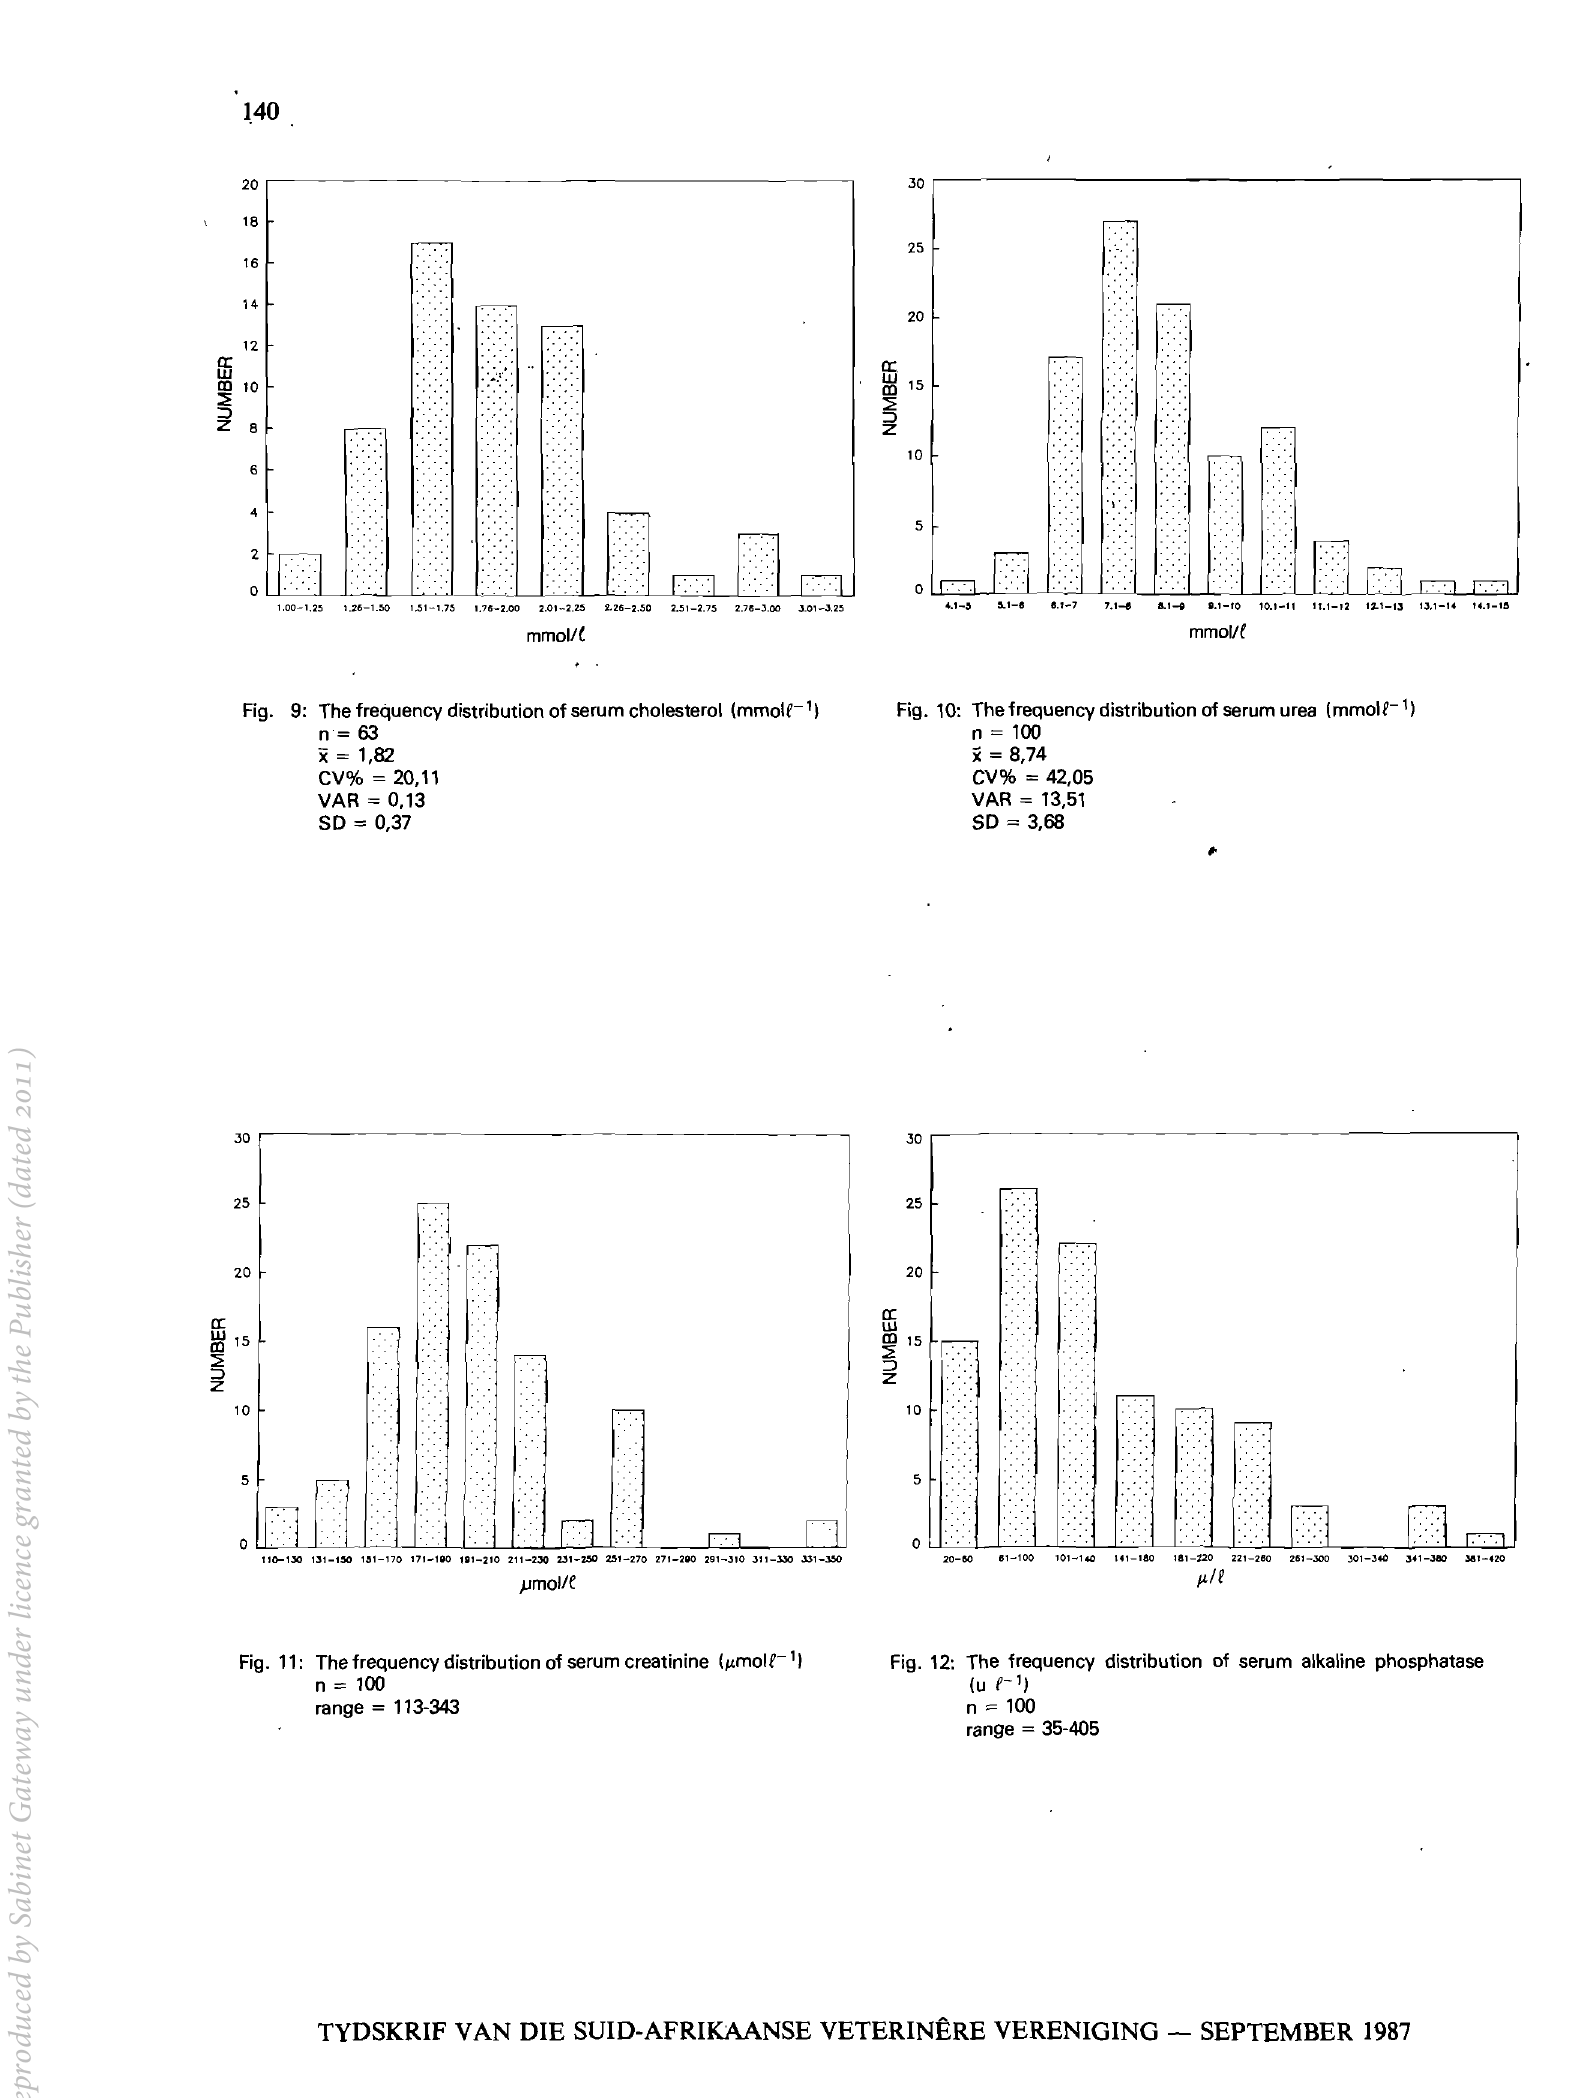
TYDSKRIF VAN DIE SUID-AFRlKAANSE VETERINERE VERENIGING -- SEPTEMBER